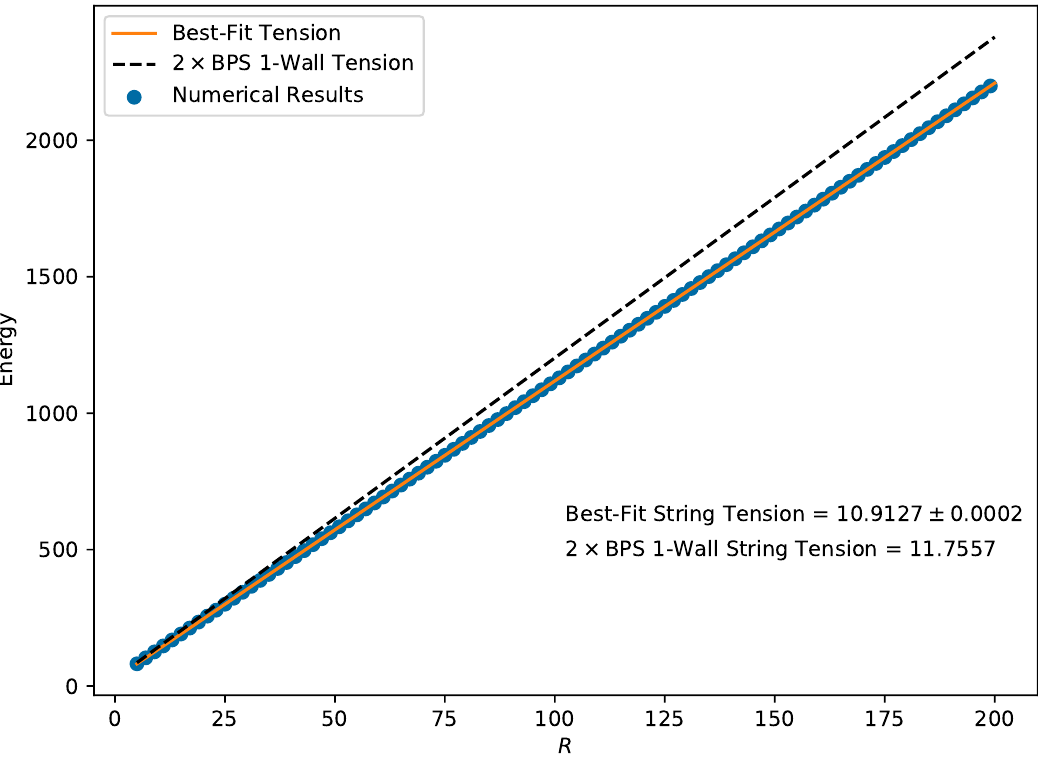
Figure 9. The energy of the fundamental confining strings for SU(5) , up to a quark separation of R = 200 . This shows that the binding of two BPS 1-walls into a single string persists to large distances and is not a short-distance